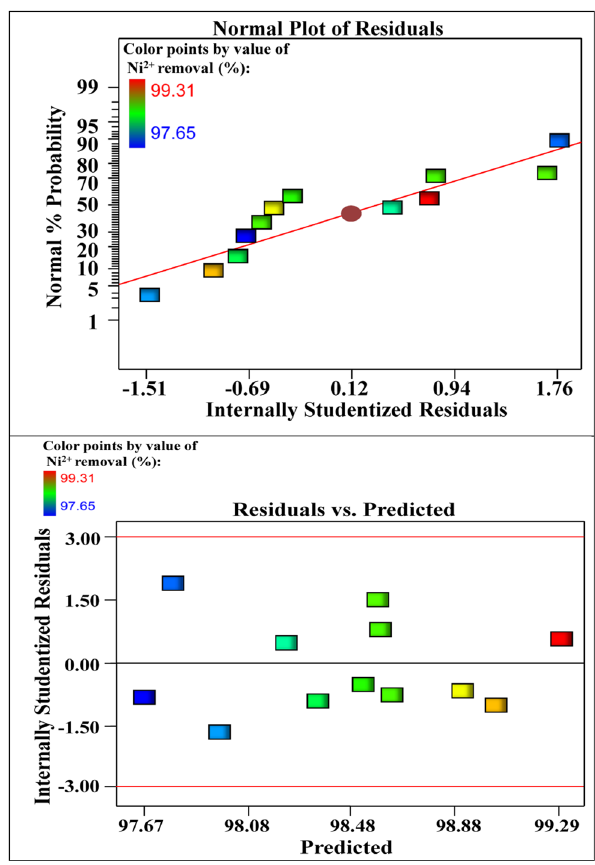
Figure 2: NPP of the residuals and residuals vs predicted Ni 2 ++